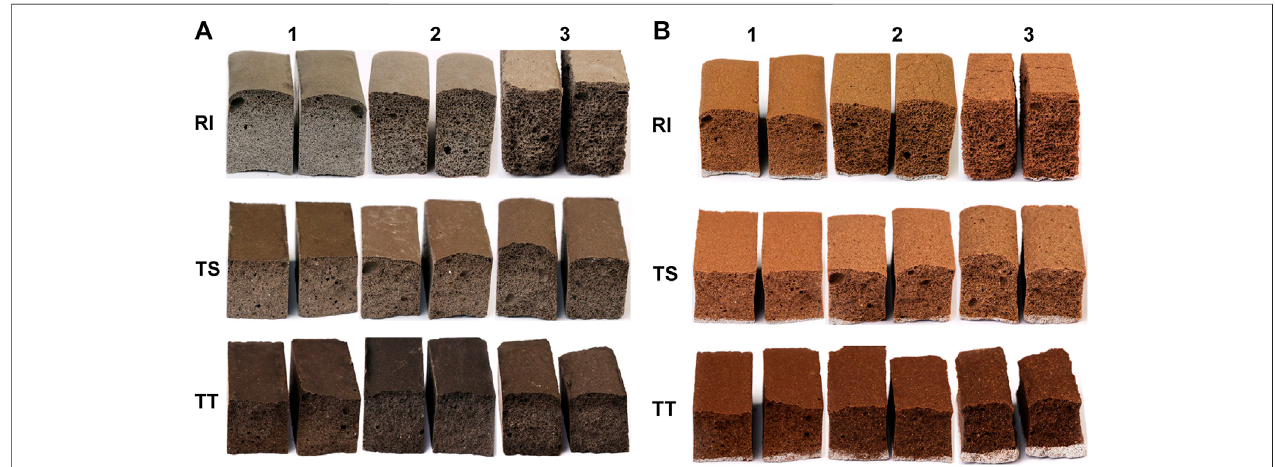
FIGURE 1 | Alkali-activated foams (A) cured at 70 ° C and (B) thermally treated to 1,000 ° C (two samples per mixture).